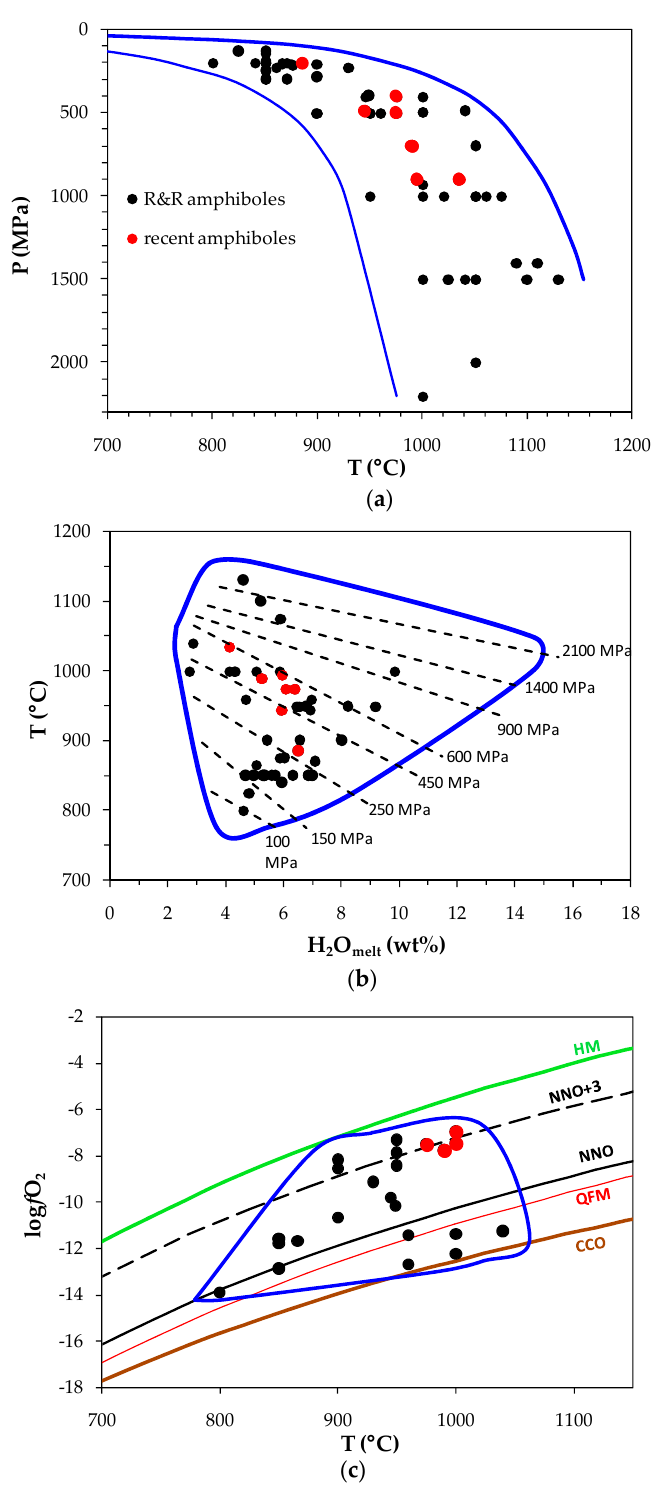
Figure 2. ( a ) P vs. T, ( b ) T vs. H 2 O melt , and ( c ) log f O 2 vs. T diagrams for the experimental amphiboles selected in this work (both recent and those in [10], i.e., R&R). The blue curves are drawn by considering the uncertainties of Amp-TB2.xlsx and delimit the validity of the method. The dashed lines in ( b ) show isobars, whereas ( c ) reports the most common metal-metal oxide buffers according to [45].